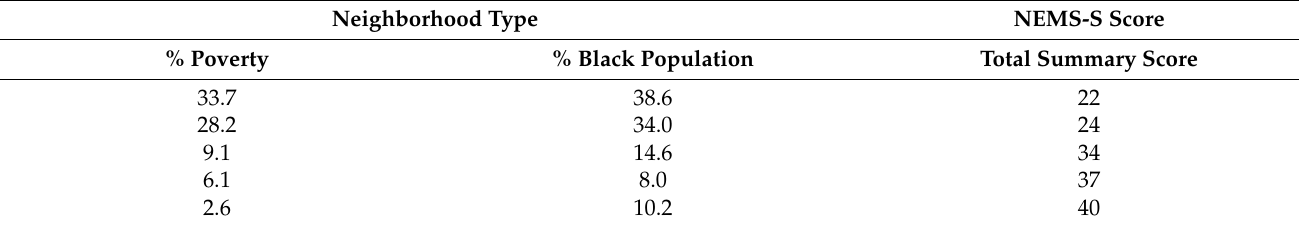
Table 2. NEMS-S Score of Grocery Stores Categorized by Neighborhood